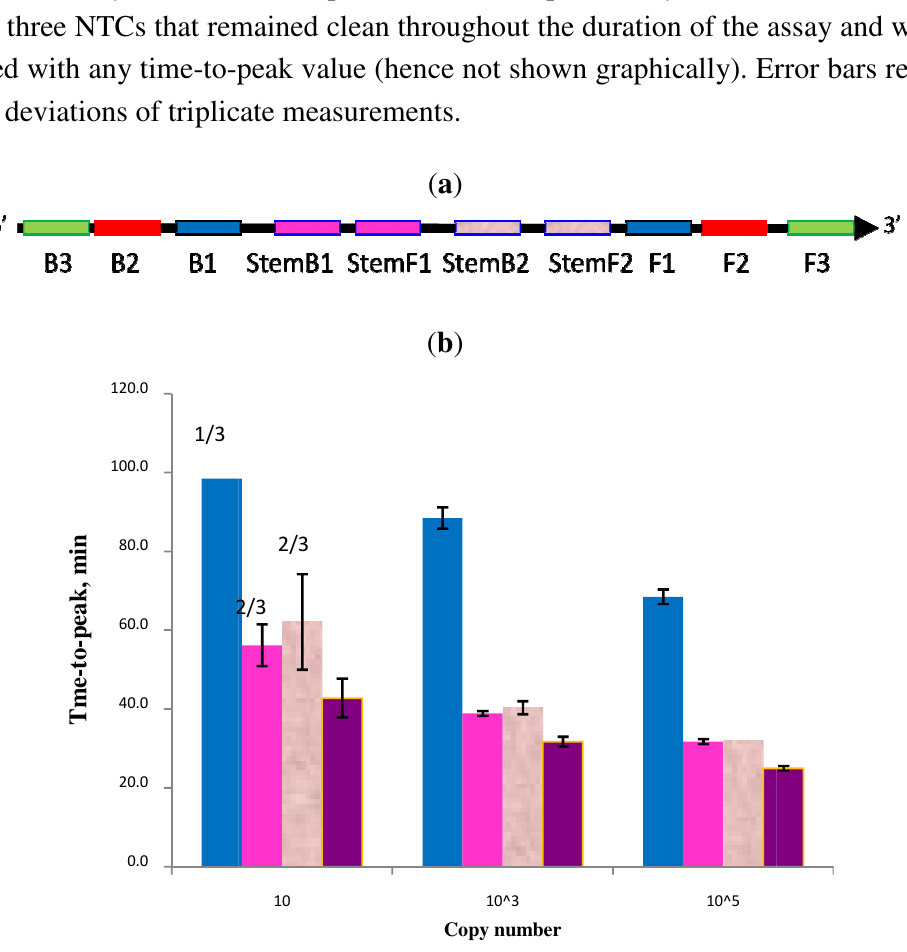
Figure 6. Schematic diagram of all priming sites used in multiplexed Stem primers ( presence of Stem primers for 10,